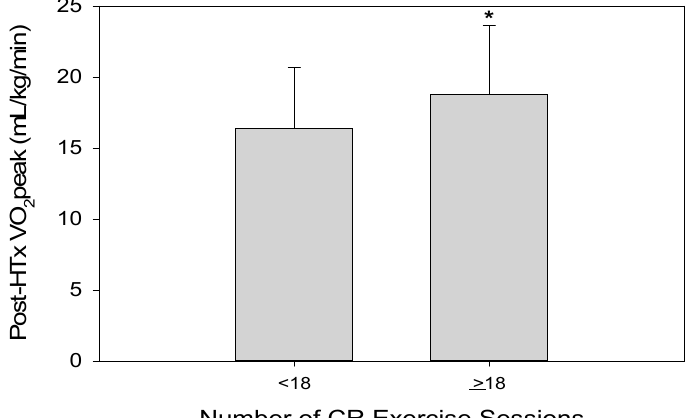
Figure 3. Post-HTx VO 2peak based on median CR exercise session attendance. Those HTx patients who attended ≥ 18 CR exercise sessions had significantly higher post-HTx VO 2peak compared to those with <18 CR exercise sessions attended ( ≥ 18 sessions: 18.8 ± 4.8 vs. <18 sessions: 16.4 ± 4.3, p < 0.01) *,